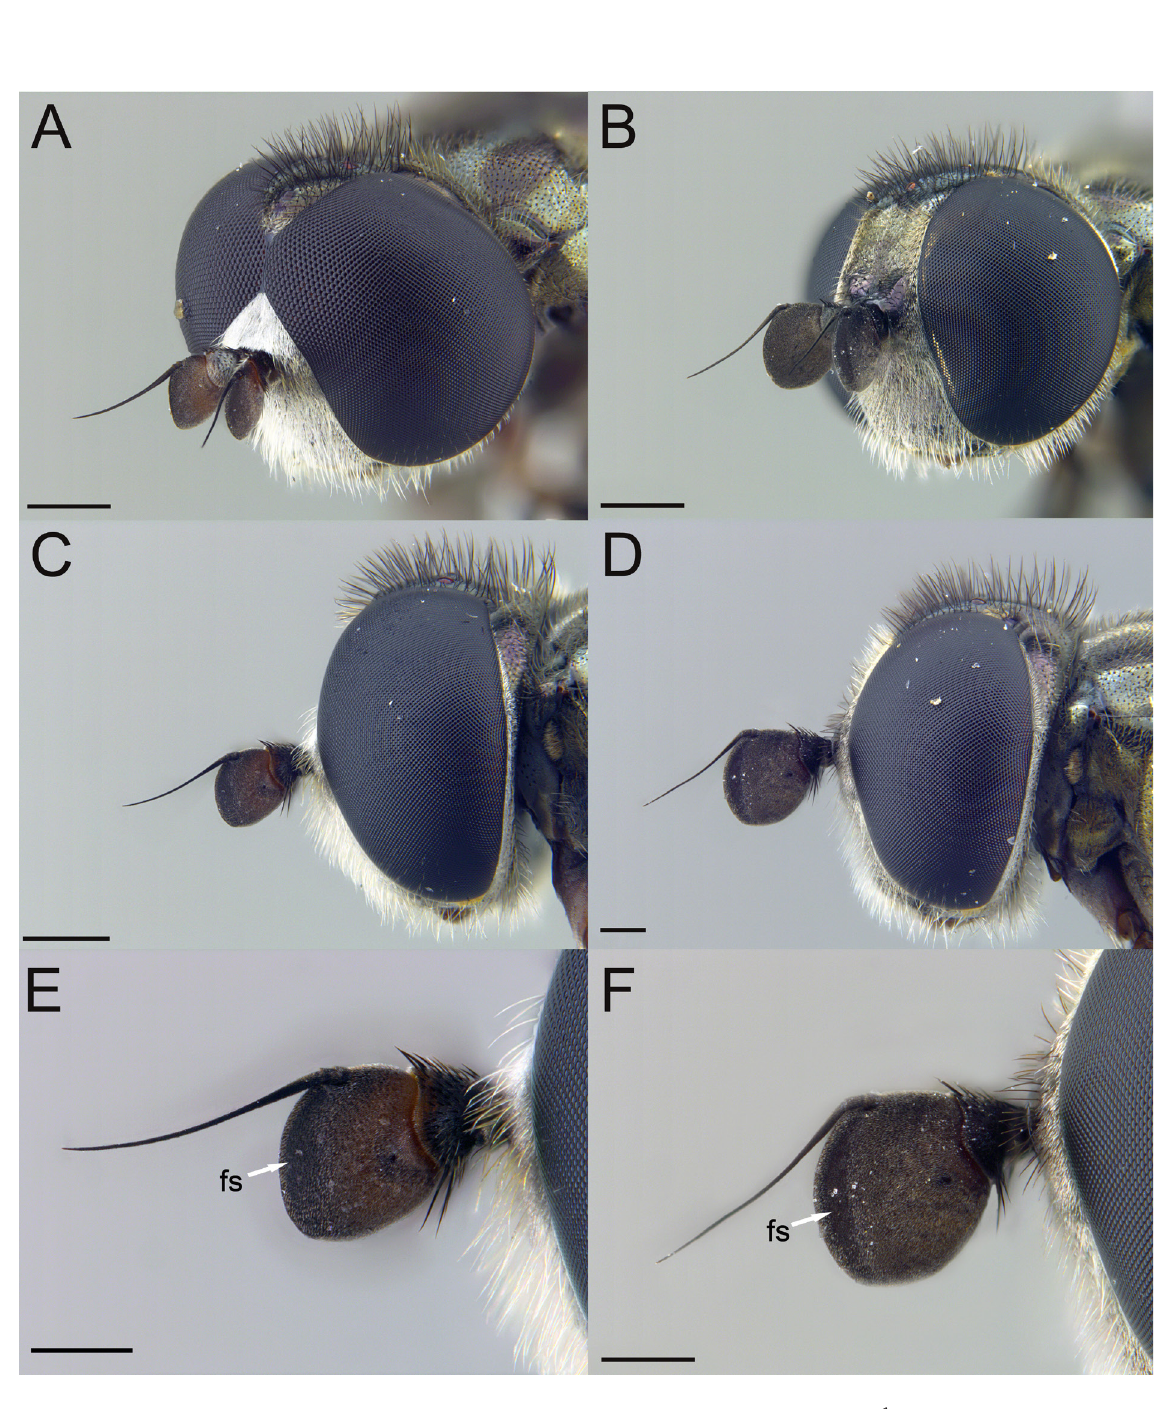
Fig. 3. Eumerus colladoi Ricarte & Aguado-Aranda sp. nov. A . Holotype, ♂ (CEUA-CIBIO), head, general view. B . Paratype, ♀ (CEUA-CIBIO), head, general view. C . Holotype, ♂, head, lateral view. D . Paratype, ♀ (CEUA-CIBIO), head, lateral view. E . Holotype, ♂, antenna, lateral view. F . Paratype, ♀ (CEUA-CIBIO), antenna, lateral view. Abbreviation: fs = fossette. Scale bars: A–C = 500 μm; D–F = 250